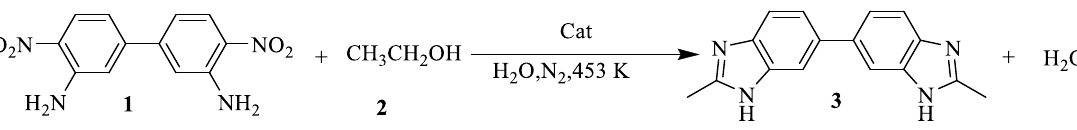
2 O 3 measured after